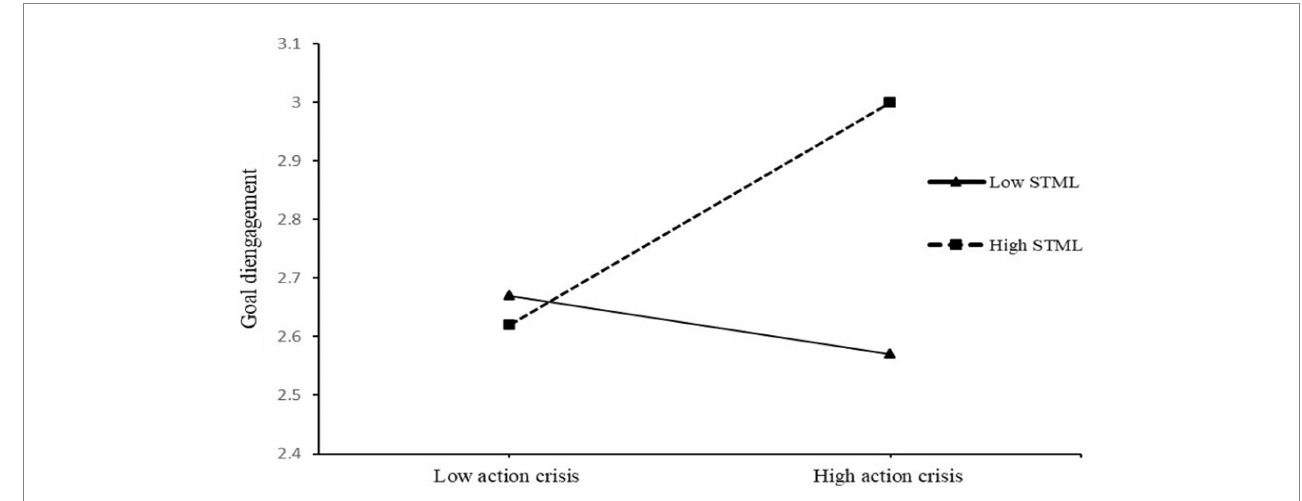
FIGURE 2 Effects of action crisis and self-transcendence meaning of life on goal disengagement in Study 1. STML, self-transcendence meaning of